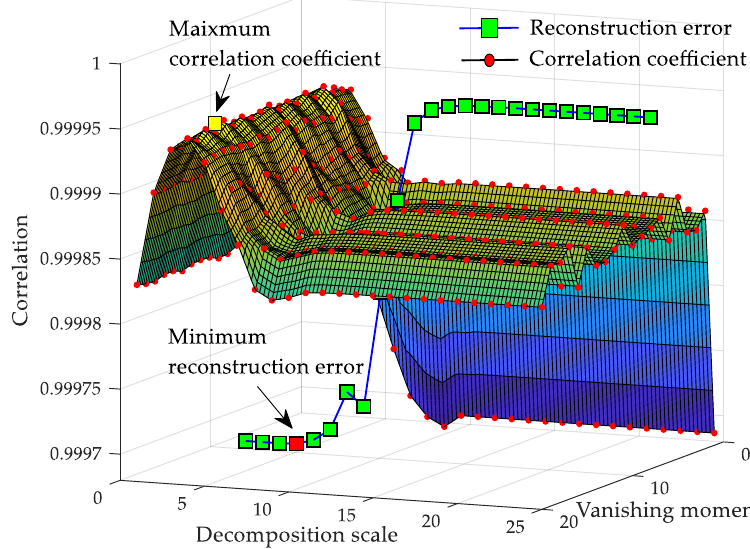
ffi cient and reconstruction error trend under Symlets wavelet Figure 8. Correlation coefficient and reconstruction error trend under Symlets wavelet processing. Figure 8. Correlation coe